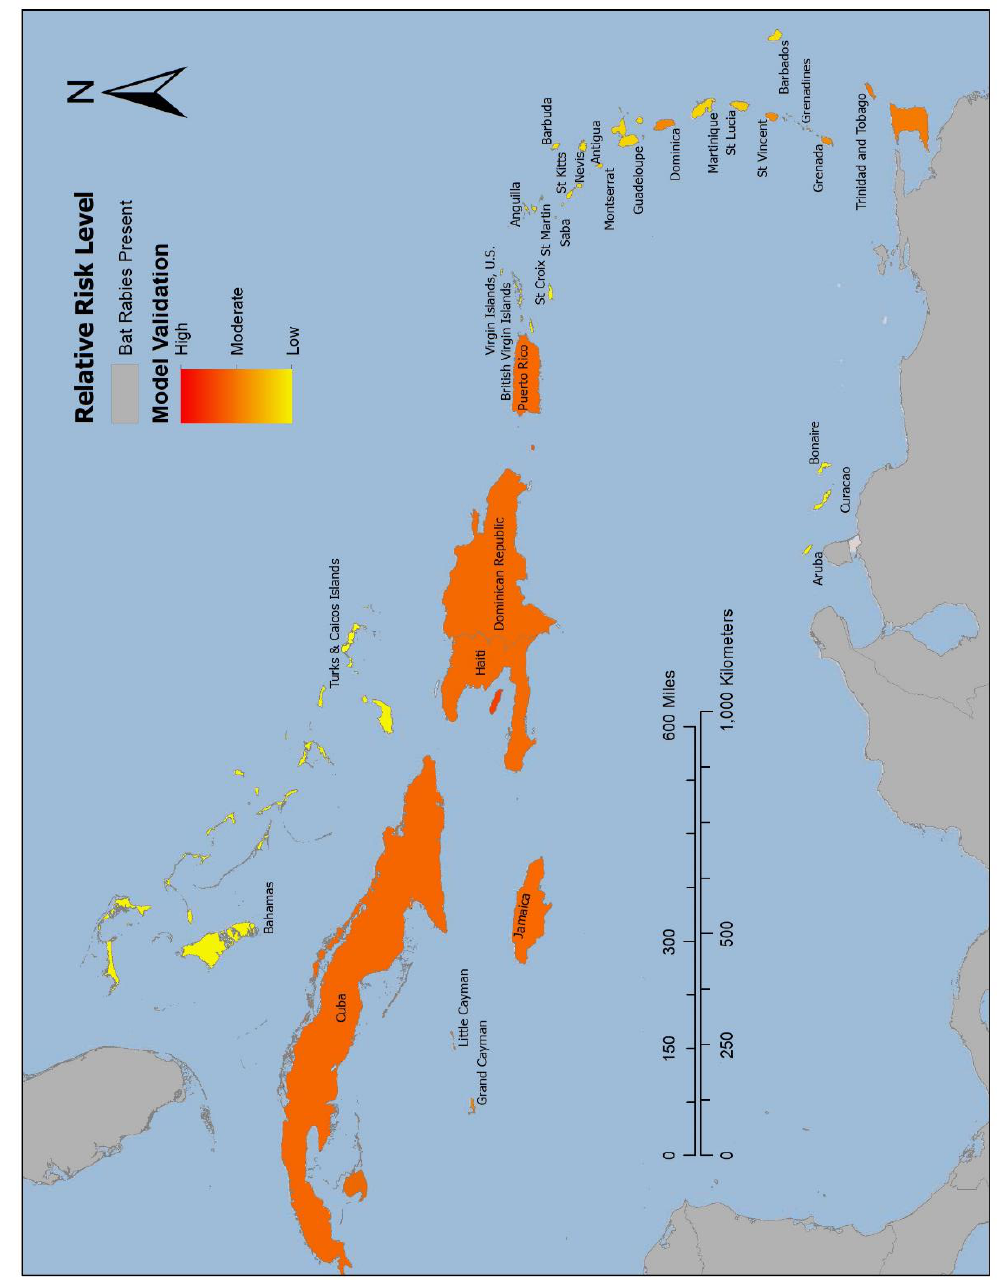
Figure 3. Map displaying results of the validation model. The validation model was created to assess the predictive capabilities of an Analytic Hierarchy Process (AHP) risk model to assign risk values to Caribbean islands representative of their likelihood of unrecognized bat-associated transmission of rabies virus (UBAT-RV). In the validation model, all RFs within the geospatial calculation signifying “having bat rabies” were removed from islands in which bat rabies has been detected. The validation model results determined that there was higher risk of enzootic rabies virus transmission in bats on islands that have documented laboratory confirmed rabid bats, signifying the predictive capabilities of an AHP risk model. Areas of high risk are symbolized by red and orange, and lower risk is symbolized yellow.